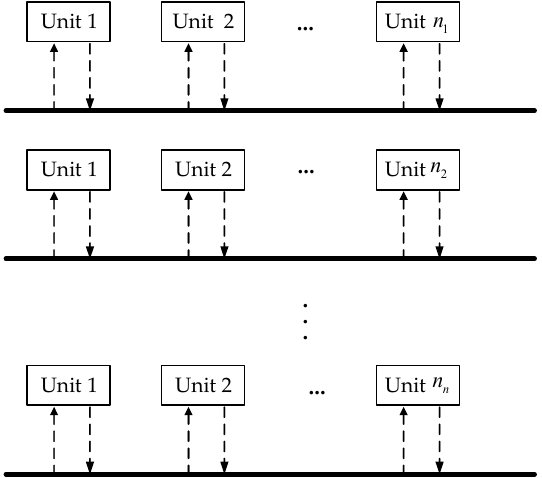
Figure 1. Composition of the system with multiple operation mechanisms .